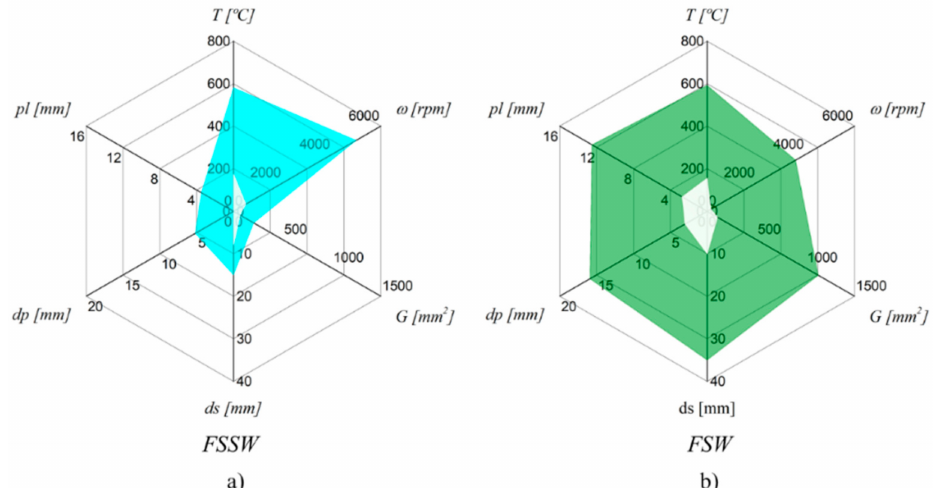
Figure 1. Range of welding temperatures (T) recorded and rotational speeds ( ω ), geometry parame- ters (G), pin lengths (p l ), shoulder (d s ) and pin (d p ) diameters used in the works of Table 1, for the ( a ) FSSW and ( b ) FSW